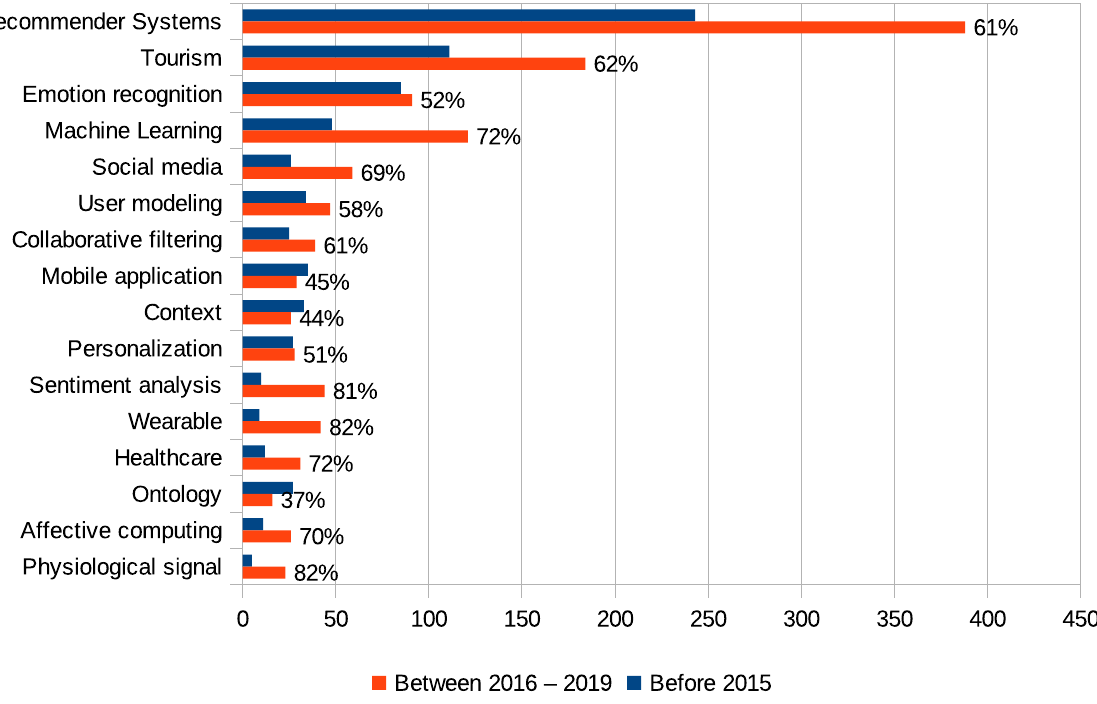
Figure 2. Research topics related to recommender systems, tourism, and emotion detection between 2001 and